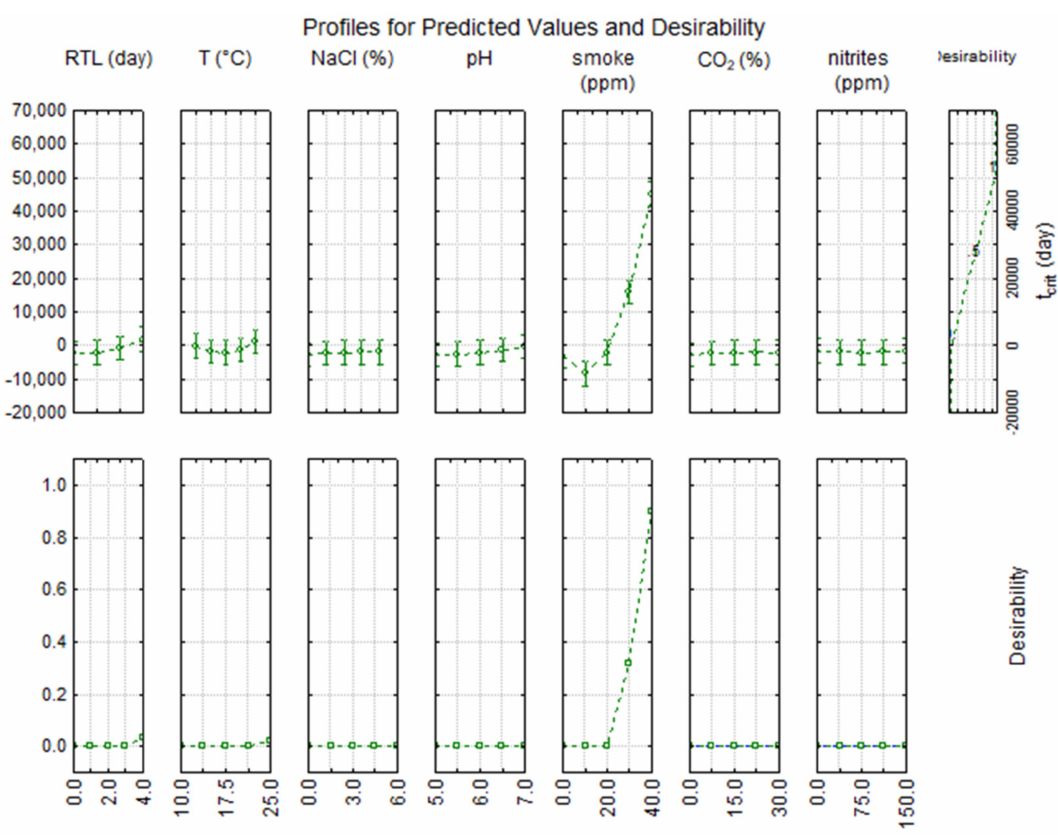
Figure 4. Desirability profile for the time to attain the steady state (t crit ) of lactic acid bacteria in fish